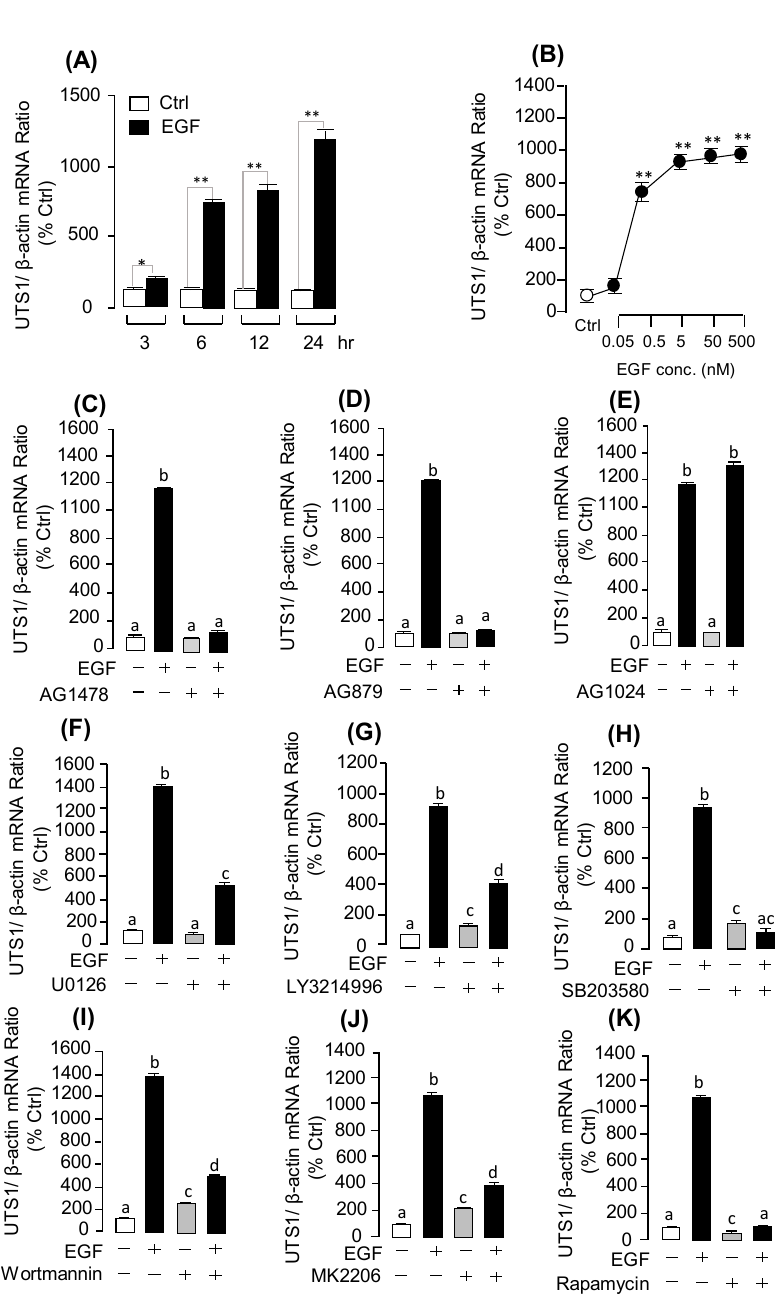
Figure3. Synergistice ff ectsofEGFon UTS1 Figure 3. Synergistic effects of EGF on UTS1 mRNA expression and receptor specificity and post- receptor signal pathway of EGF (0.5 μ M)-induced UTS1 mRNA expression in grass carp pituitary cells. ( A ) Time course of EGF (0.5 μ M) treatment on UTS1 mRNA expression. ( B ) Effect of EGF concentration (0.05–500 nM)-induced on UTS1 mRNA expression in grass carp pituitary cells. ( C–E ) Effects of ErbB1 antagonist AG1478, ErbB2 antagonist AG879, and IGF receptor antagonist AG1024 on EGF-induced UTS1 mRNA expression, respectively. ( F – H ) The effects of EGF (0.5 μ M) induced UTS1 mRNA transcription with the MEK inhibitor U0126 (10 μ M), ERK1/2 inhibitor LY3214996 (10 μ M), and p38MAPK inhibitor SB203580, respectively. ( I – K ) Co-treatment with the PI 3 K inhibitor Wortmannin (10 μ M), AKT inhibitor MK2206 (10 μ M), and mTOR inhibitor Rapamycin (10 μ M) on EGF (0.5 μ m)-induced UTS1 mRNA expression for 24 h, respectively. After drug treatment, total RNA was isolated and used for real-time PCR of UTS1 mRNA expression. The differences between groups were considered as significant at p < 0.05 (“*”) or highly significant at p < 0.01 (“**”). The groups denoted by different letters represent a significant difference at p < 0.05.